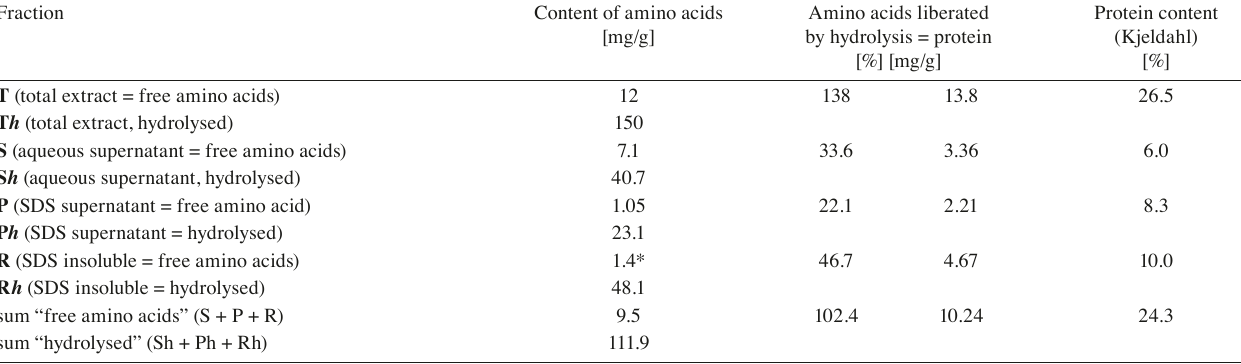
Tab. 2: Protein content in M. oleifera leaves estimated on the basis of acidic protein hydrolysis.